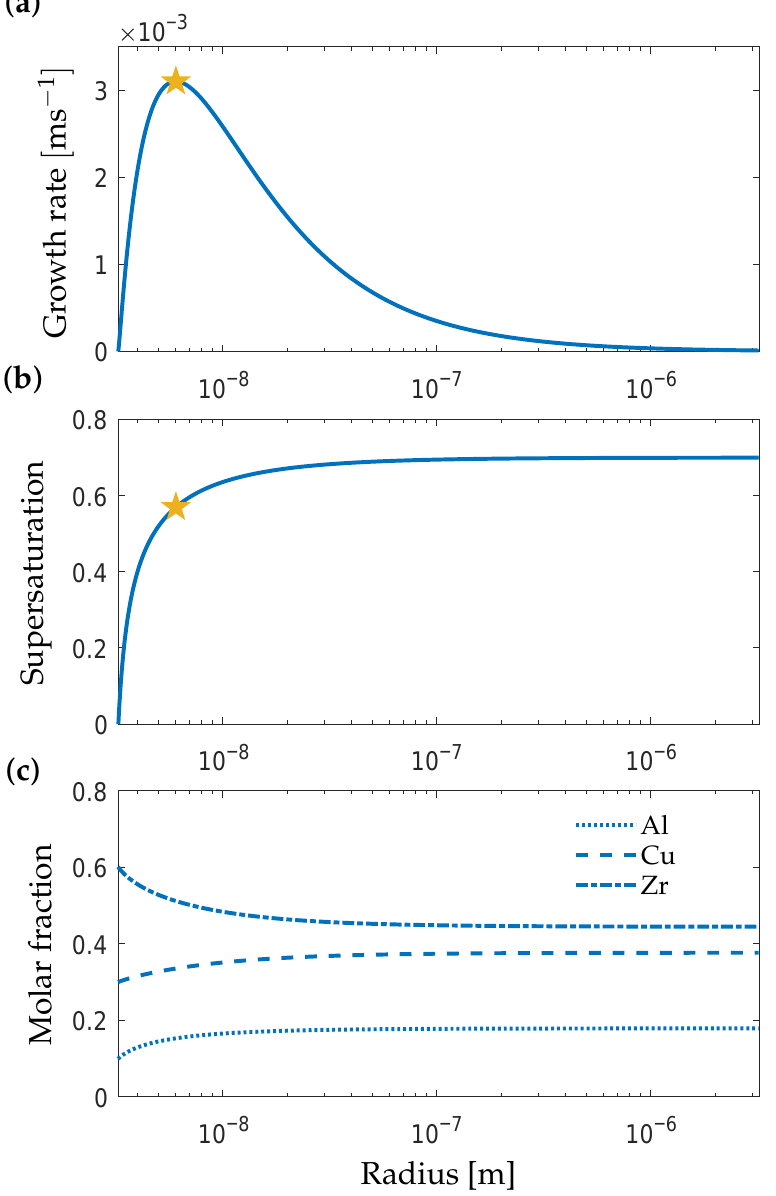
αβ as a as a i i